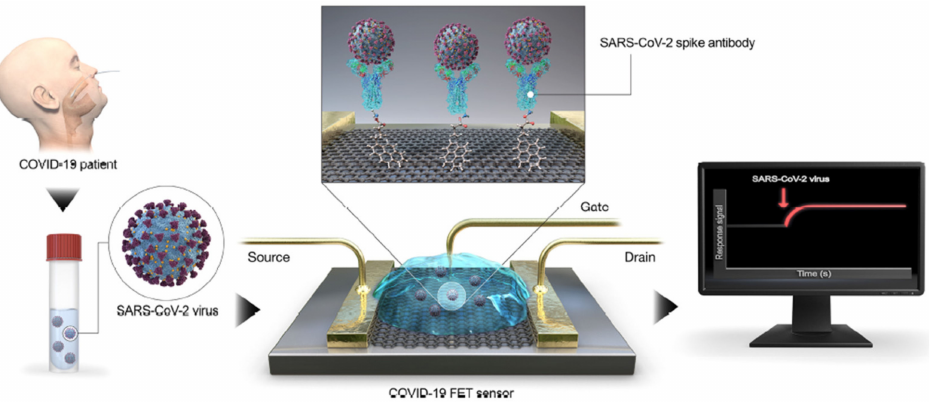
Figure 4. Schematic diagram of COVID-19 FET sensor operation procedure (reprinted from Ref. no. [82], copyright 2020, American Chemical Society).